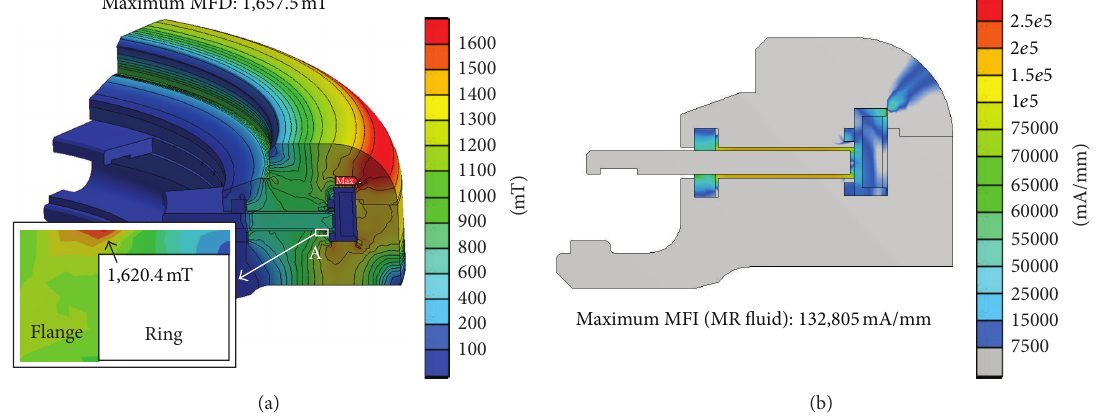
Figure 6: FEA results of the rotary MR damper (Model A). (a) Magnetic flux density (MFD). (b) Magnetic field intensity (MFI).